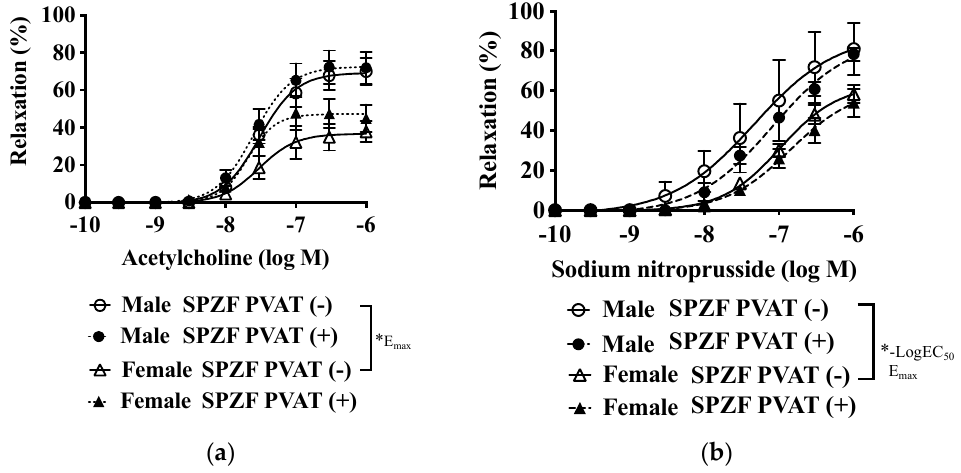
Figure 1. Vascular relaxation in response to acetylcholine ( a ) and sodium nitroprusside ( b ) in renal arteries with or without perivascular adipose tissues [PVAT (+/ − )] of male and female SHRSP.Z- Lepr fa /IzmDmcr rats (SPZF) at 23 weeks of age. Arterial rings were submaximally contracted by phenylephrine to determine the acetylcholine and sodium nitroprusside dose–response curves. Data are expressed as means ± SEM. n = 9 rats/group. * p < 0.05. Statistical comparisons of means between groups were performed using a two-way ANOVA followed by Bonferroni post-hoc test. Table 2. Relaxation and contractile response in renal arteries with (+) or without ( − ) perivascular